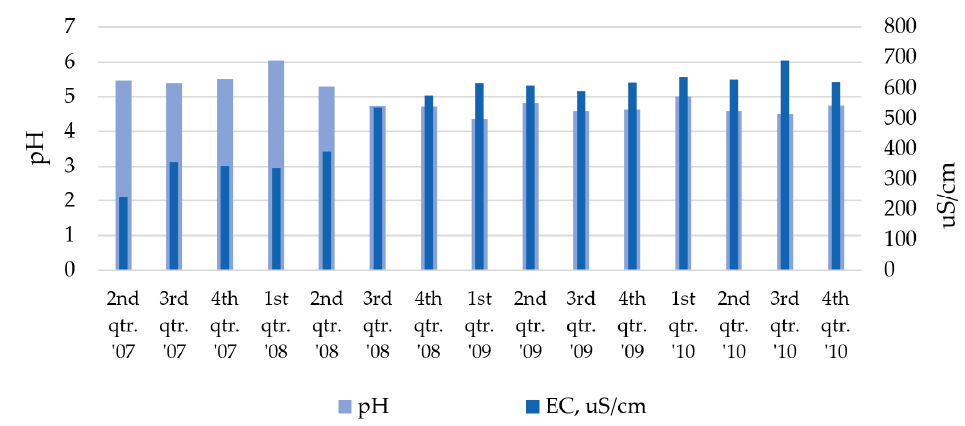
Figure 2. Average EC and pH values for groundwater collected from piezometers: P 1, P 12, P 15, P 16, P 17 (April 2007 to December 2010).